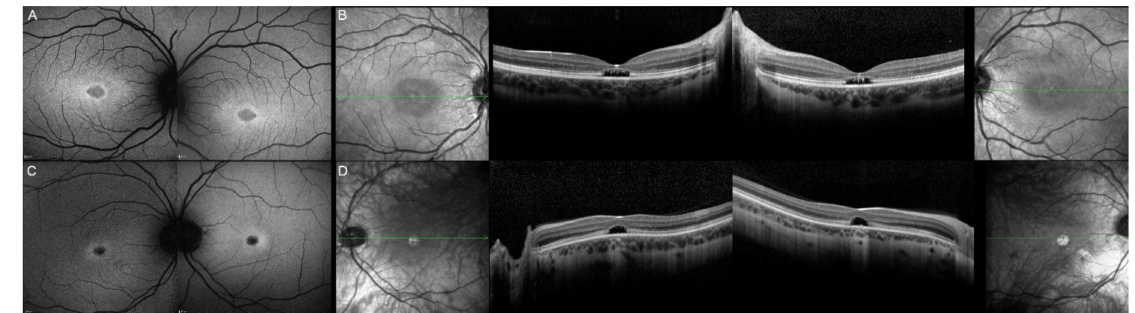
Figure 15. “Bull’s eye like” clinical phenotype. FAF ( A ) and OCT ( B ) imaging of STGD1 patient 2/II.1 compound heterozygous for the c.1760+2T>C p.? and c.3727T>G p.(Tyr1243Asp) ABCA4 variants. FAF ( C ) and OCT ( D ) imaging of STGD3 patient 12/II.2 harboring the pathogenic c.810C>G p.(Tyr270*) ELOVL4